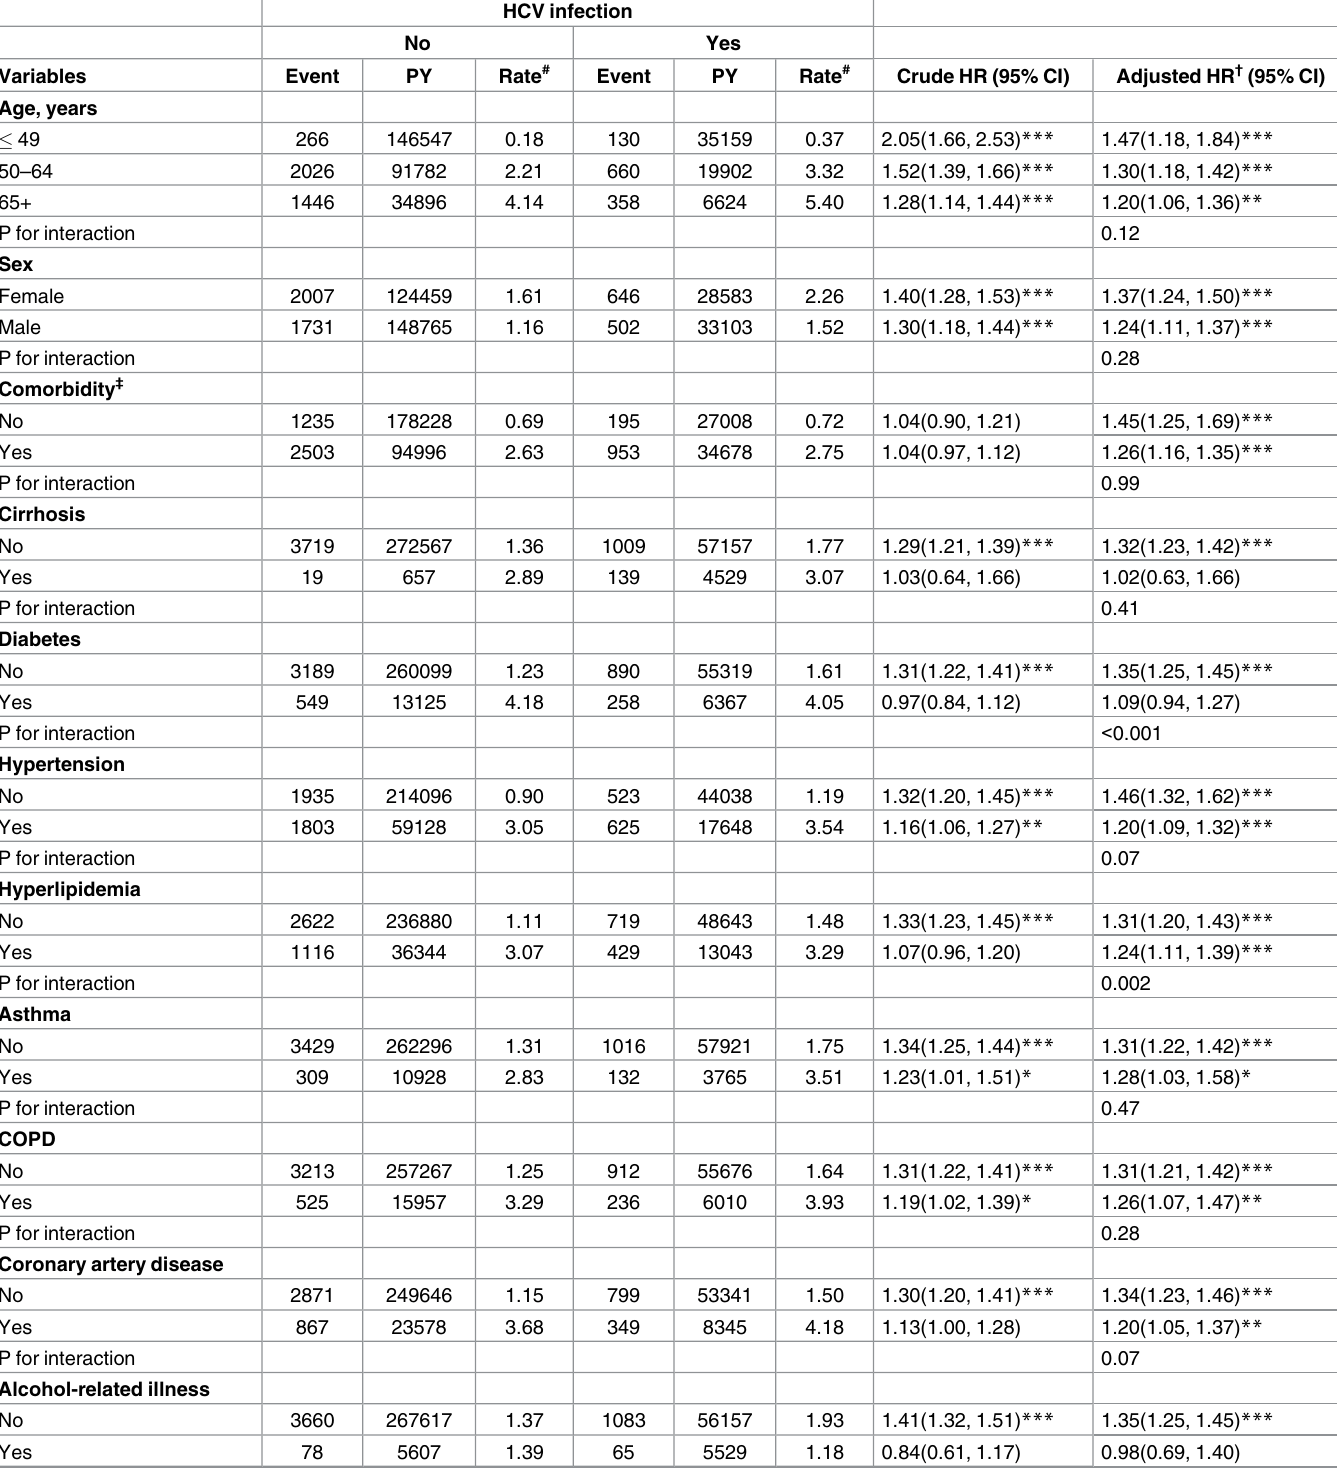
Table 3. Incidence of cataract by age, sex and comorbidity and Cox model measuredhazards ratio for patients with HCV infection compared those without HCV